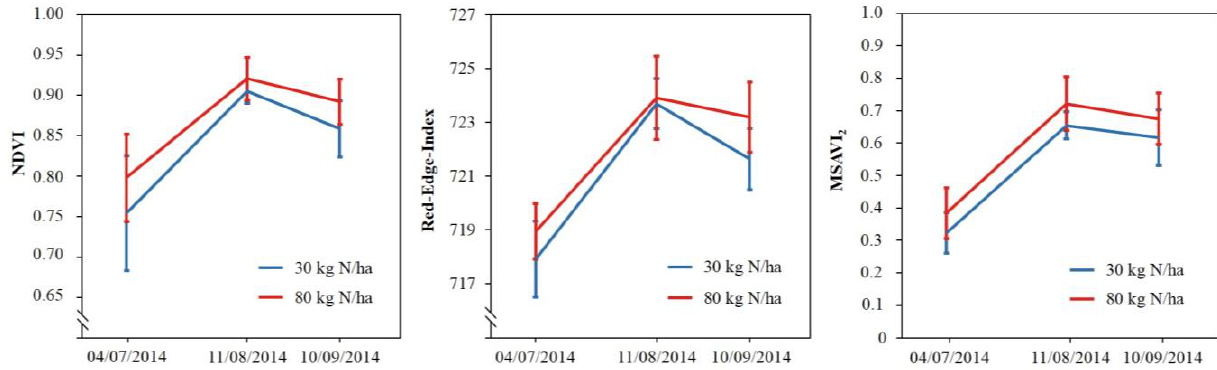
Figure 6: Mean and standard deviation of the calculated vegetation indices